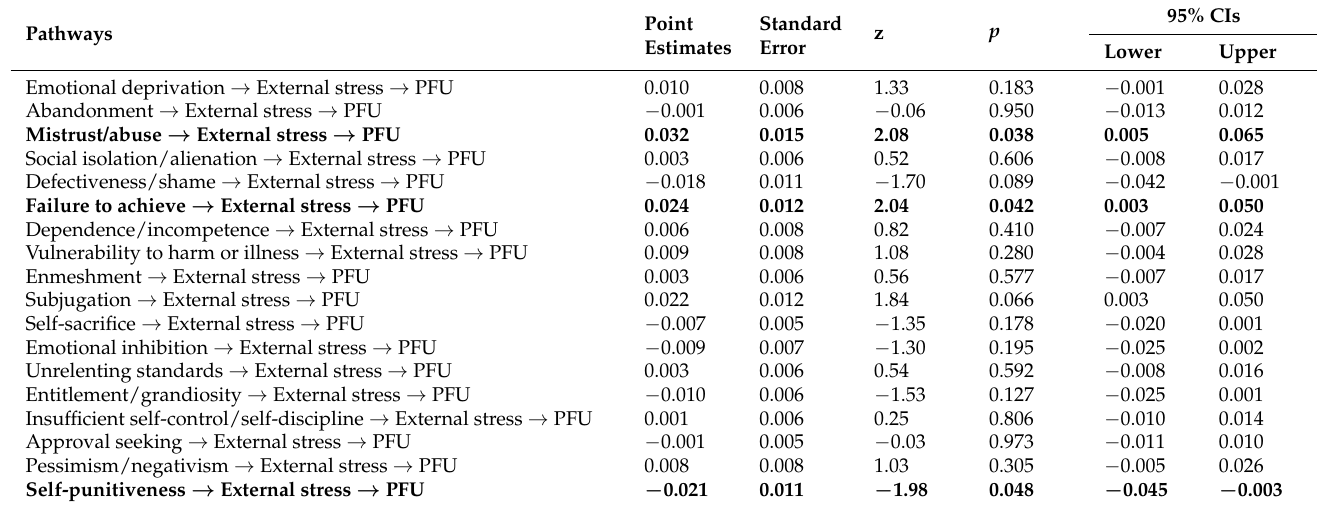
Table 5. Standardized indirect effects exerted by external stress in relationship between EMSs and PFU with 95% confidence intervals (CIs) among Facebook users (N =